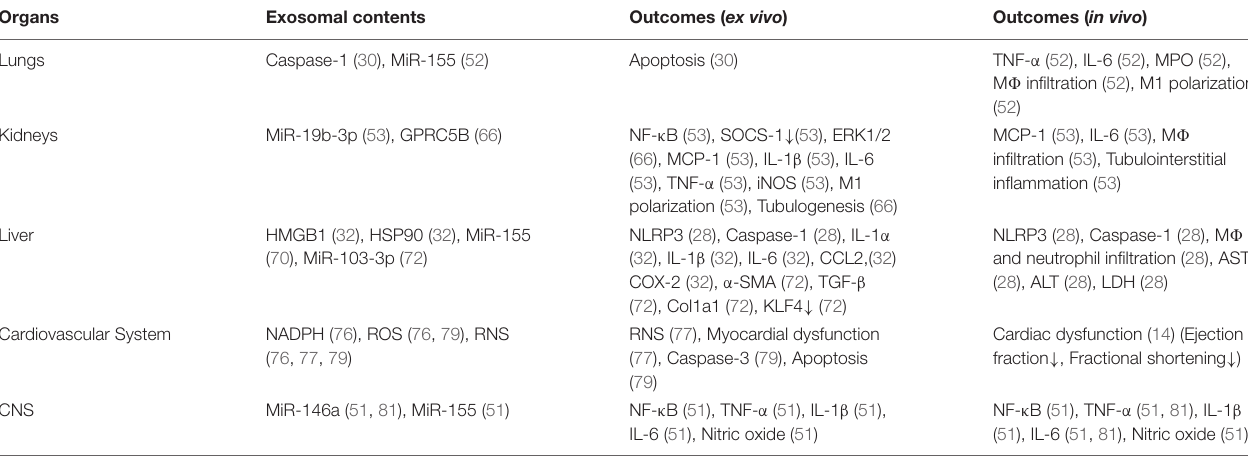
TABLE 2 | Exosomes in sepsis and their impact on organ